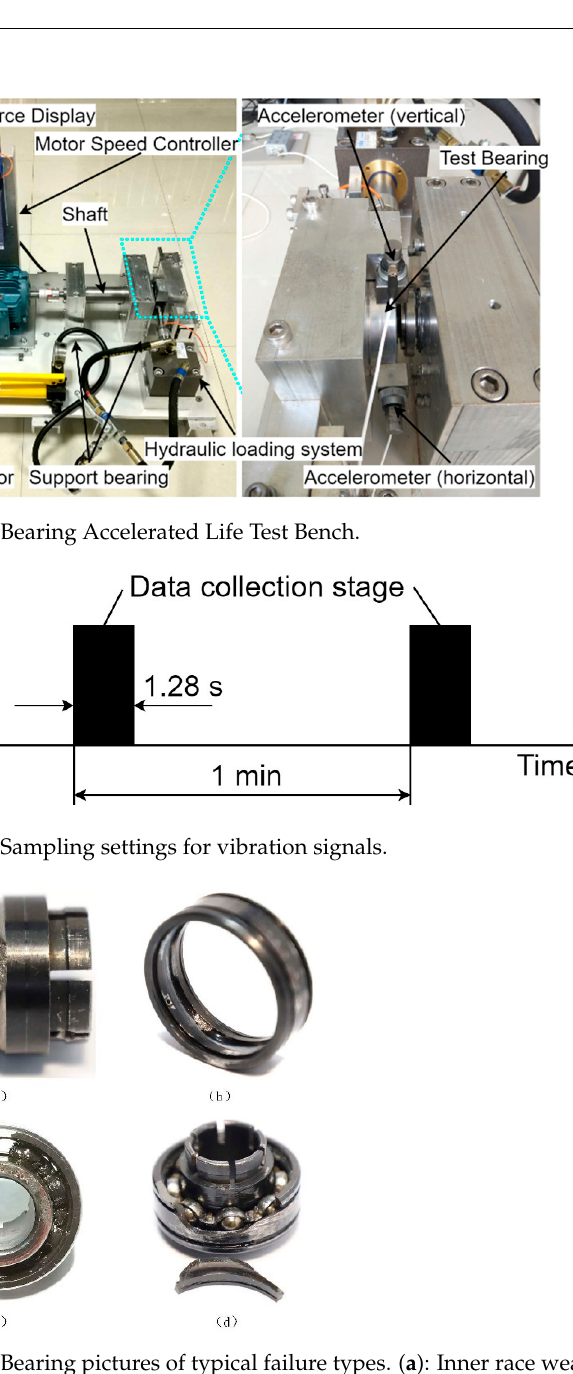
Table 3. Bearing Accelerated Life Test Conditions.